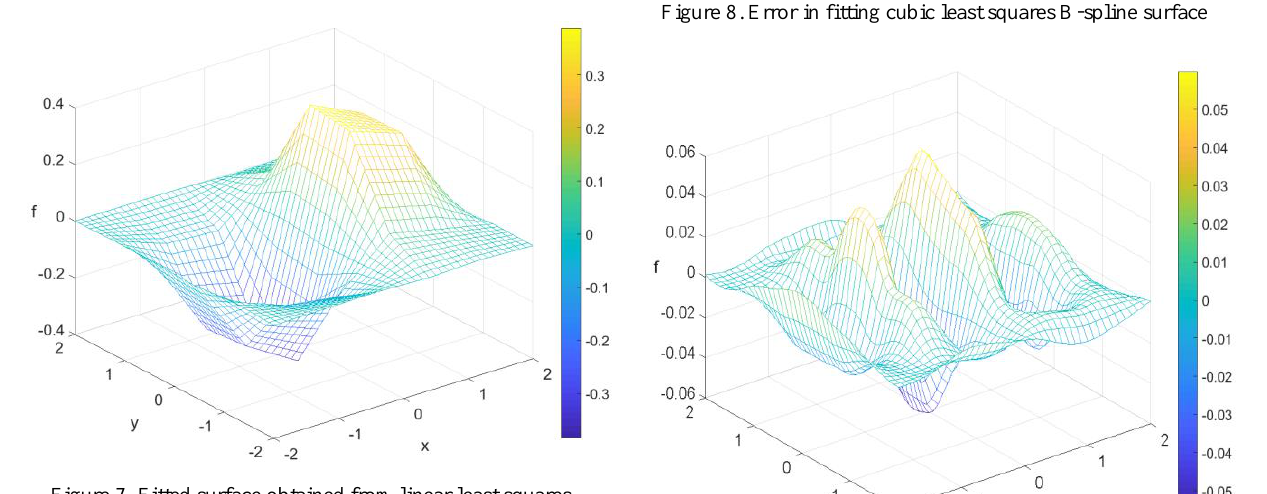
Figure 7. Fitted surface obtained from linear least squares B-spline Figure 9. Error in fitting quadratic least squares B-spline surface